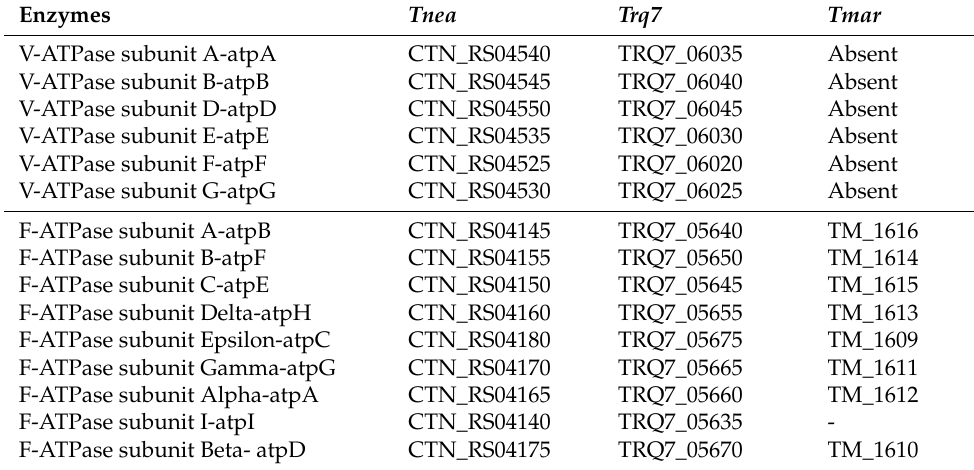
Table 2. F-type and V-type ATPases locus tags in Tnea , Trq7 , and Tmar